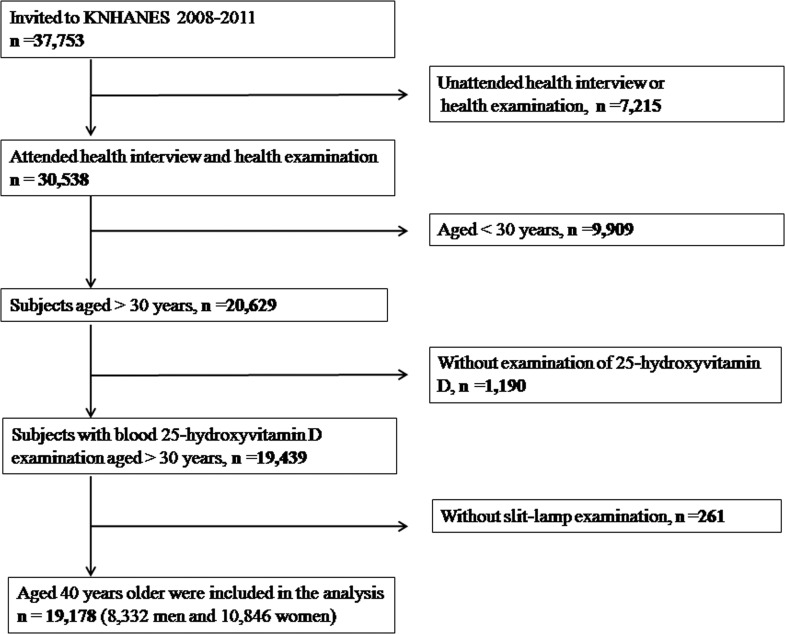
Flow diagram showing the selection of study participants.